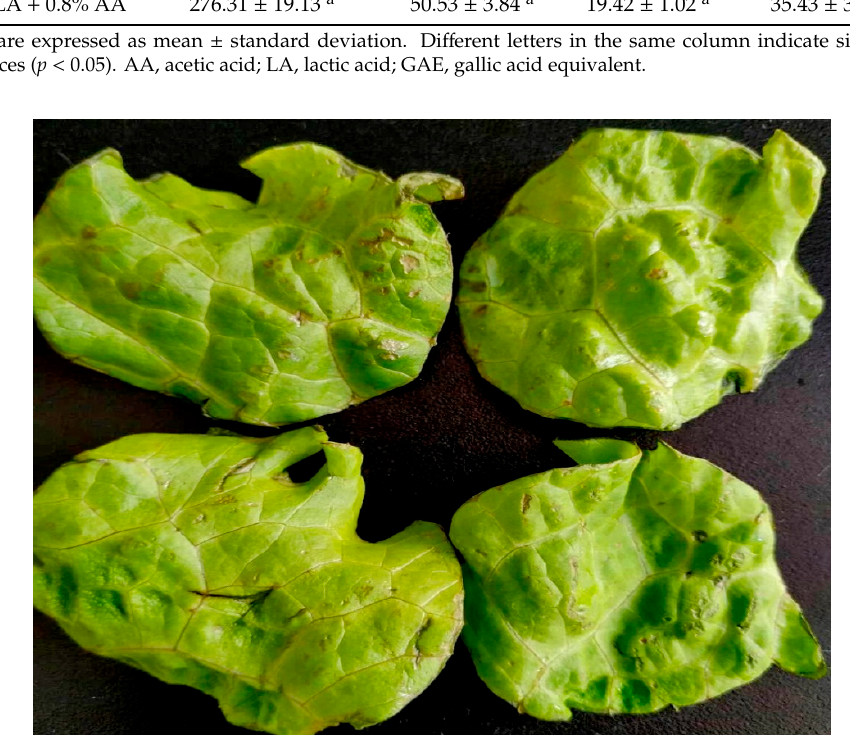
Figure 1. Visual quality-loss of lettuce samples after washing with 1% acetic acid and storage for 5